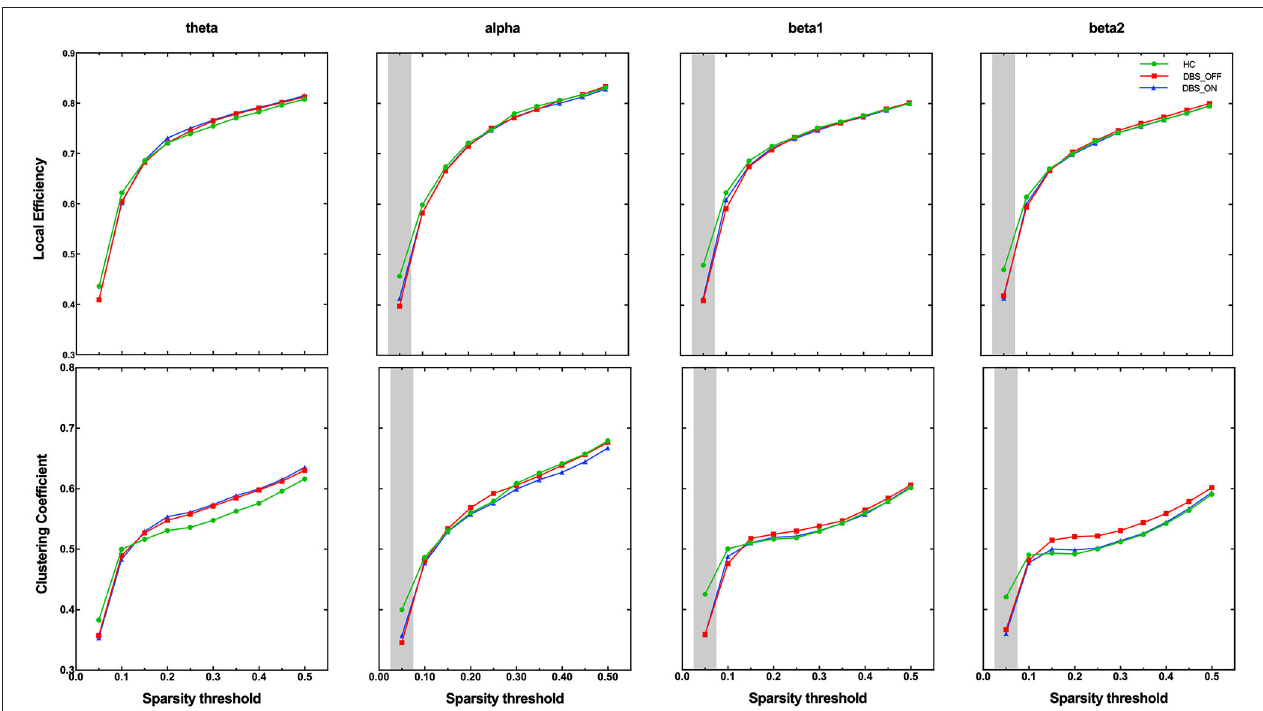
FIGURE 2 | Group comparison of the graphic index across sparsity thresholds. The grey shadings indicate significant group difference at given sparsity